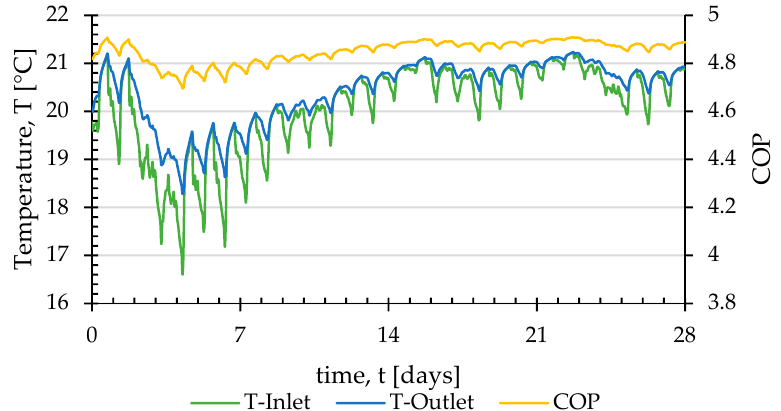
Figure 8. Energy pile temperatures and performance for the month of February.